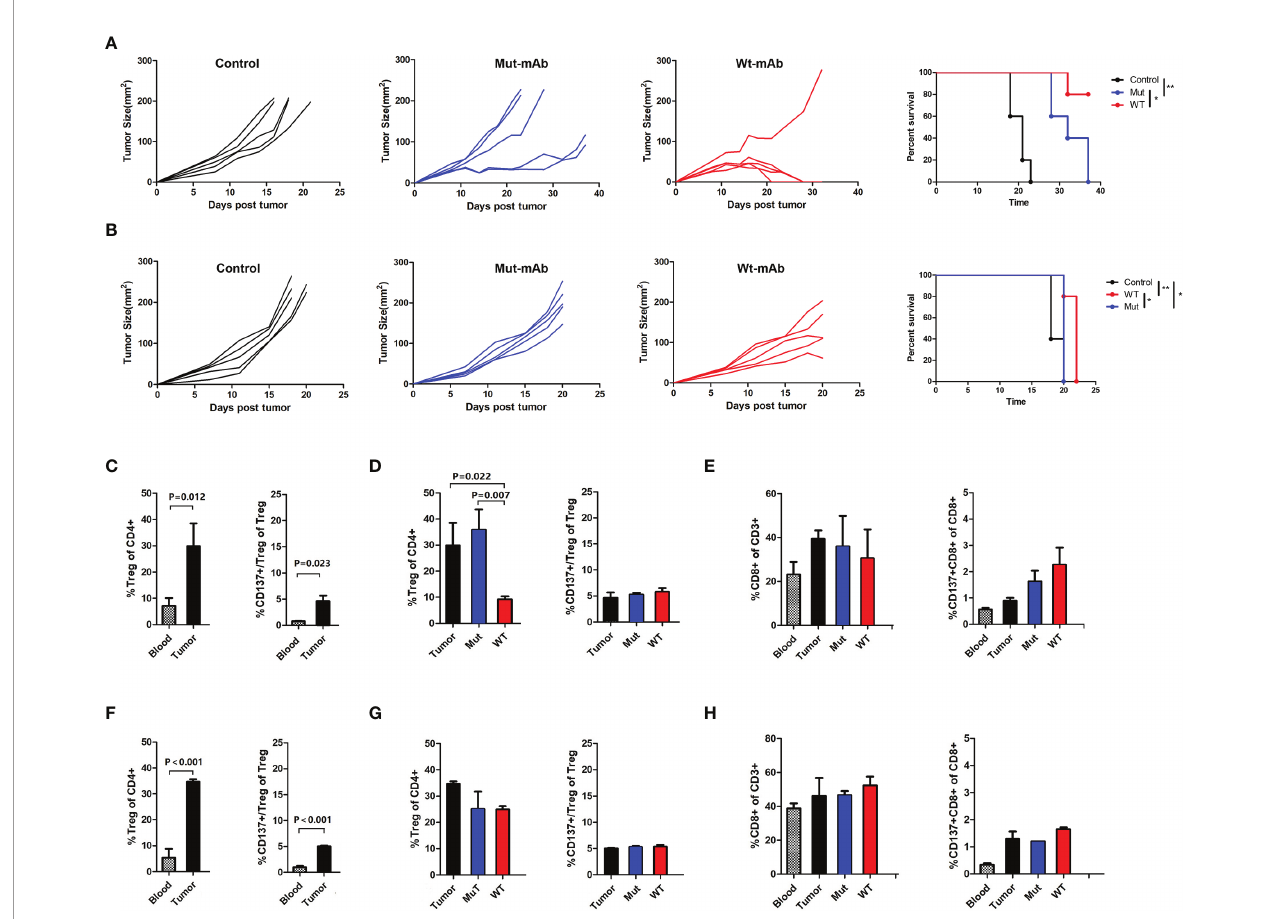
FIGURE 6 | Targeting CD137+ Tregs with Wt-mAb enhanced antitumor ef fi cacy in vivo . (A) CT26 (colon carcinoma) cells and (B) LLC cells treated with PBS (control) or the anti-CD137 mAbs Mut-mAb (with Fc mutation) and Wt-mAb (without Fc mutation). Mice (5 per group) were subcutaneously transplanted with CT26 or LLC cells. Six to 7 days later, when the tumor reached 0.5-0.7 cm in the largest diameter, the mice were injected intratumorally with mAbs (5 m g per mouse) 3 times at 2-day intervals. Tumor growth and mouse survival were monitored after transplantation. (C) The percentages of Tregs and CD137+ Tregs in blood and tumors from mice in the CT26 cell transplantation group and the changes in these percentages before and after mAb treatment (D) . (E) CD8+ T and CD137+ CD8+ T cell percentages in blood and tumors were compared before and after treatment. (F – H) The changes in the frequencies of T cell subsets were analyzed in mice in the LLC cell transplantation group as described for the CT26 cell transplantation group in (C – E) . A representative result of repeated experiments. The error bars represent the SEMs. *P < 0.05, **P <